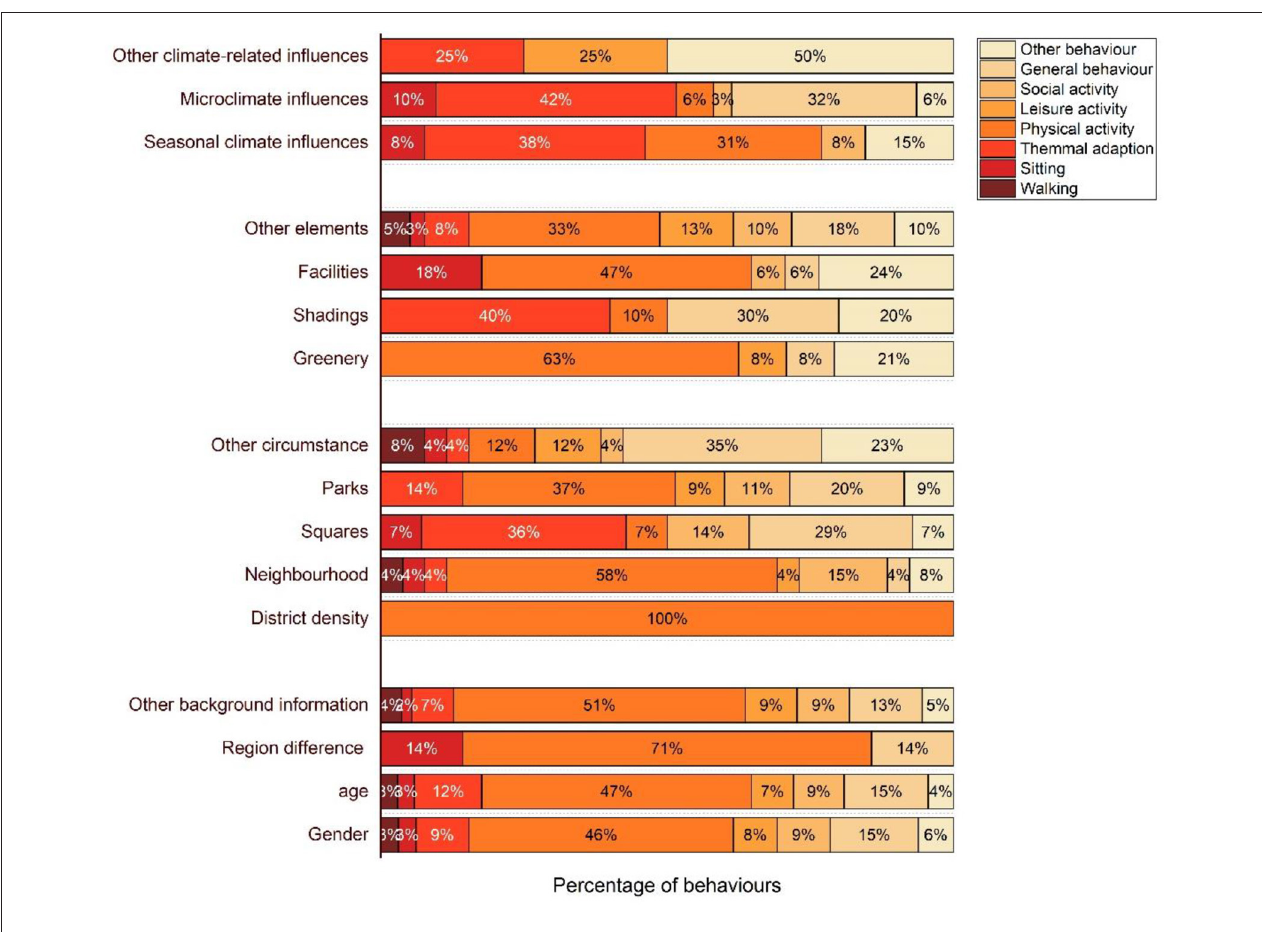
FIGURE 7 | Distribution of behaviors related to types of